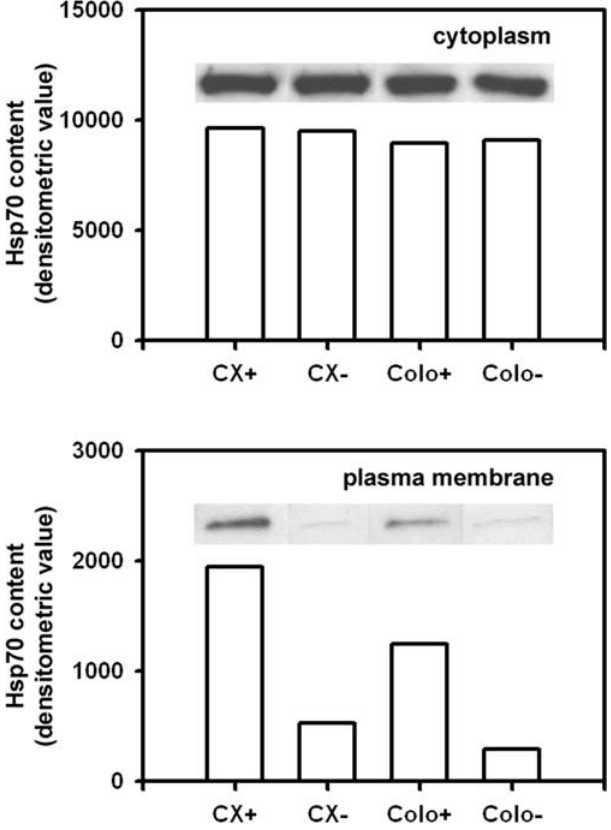
Figure 1. Quantification of cytosolic and plasma membrane- bound Hsp70 in CX + /CX 2 and Colo + /Colo 2 carcinoma sub- lines. Western blot analysis of biotinylated whole cell lysates (cytoplasm, upper graph), and plasma membranes (lower graph) of CX + /CX 2 and Colo + /Colo 2 tumor sublines. A corresponding Western blot was stained with the Hsp70 specific mAb cmHsp70.1. The figure shows a representative blot from three independent experiments. The Hsp70 surface phenotypes of the tumor sublines, as determined by flow cytometric analysis, are summarized in Table 1.